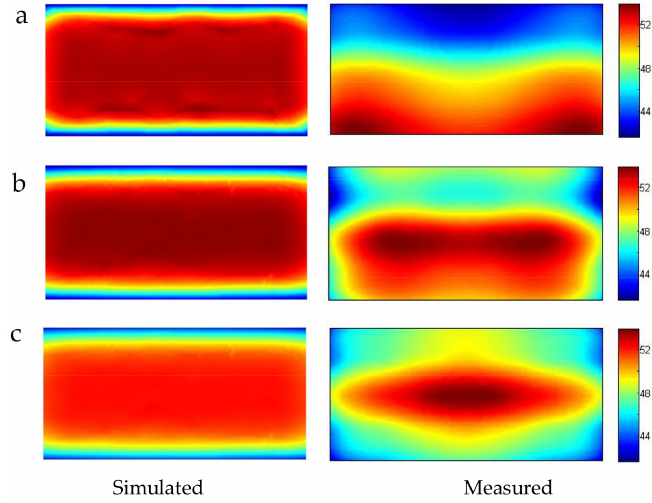
Figure 9. The simulated and measured temperature profiles at different moisture contents. ( a ) Moisture